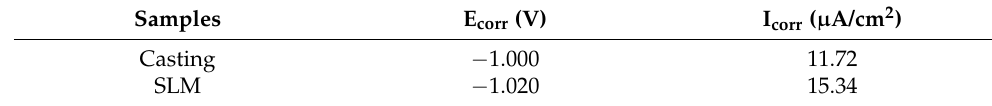
Table 2. Polarization test results for casting and SLM